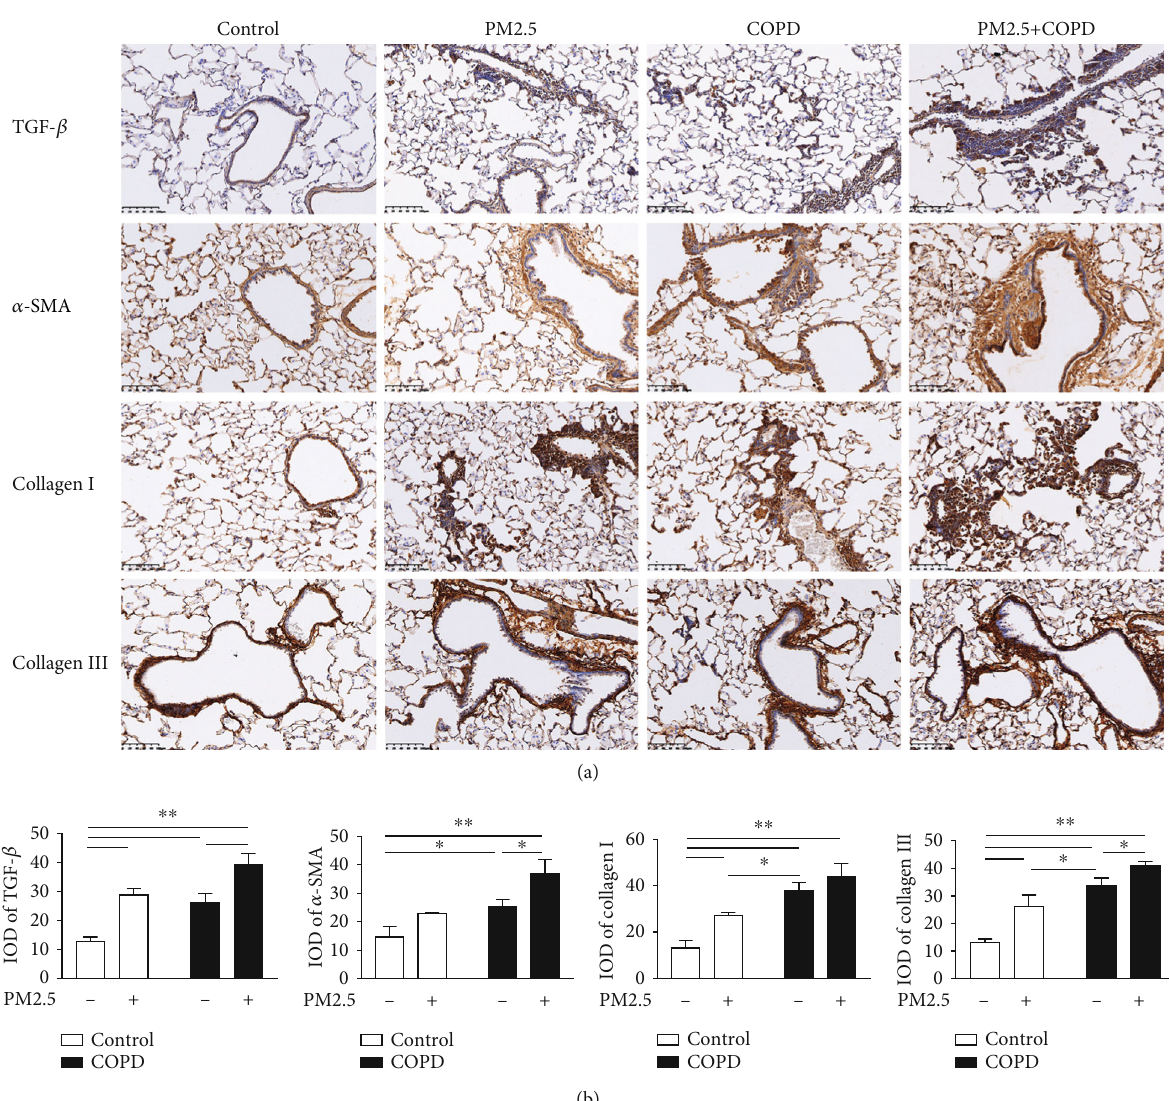
Figure 3: The e ff ect of PM2.5 on airway remodeling in rats with COPD. (a) Immunohistochemical staining of TGF- β , α -SMA, Collagen I, and Collagen III of lung sections in each group (magni fi cation, × 200). (b) Quantitative analysis of TGF- β , α -SMA, Collagen I, and Collagen III using Image-ProPlus 6.0 software. TGF- β 1: transforming growth factor-beta 1; α -SMA: α -smooth muscle-actin; IOD: integral optical density. The data are expressed as the means ± SD ( n = 6 ). ∗∗ p < 0 : 01 , ∗ p < 0 : 05